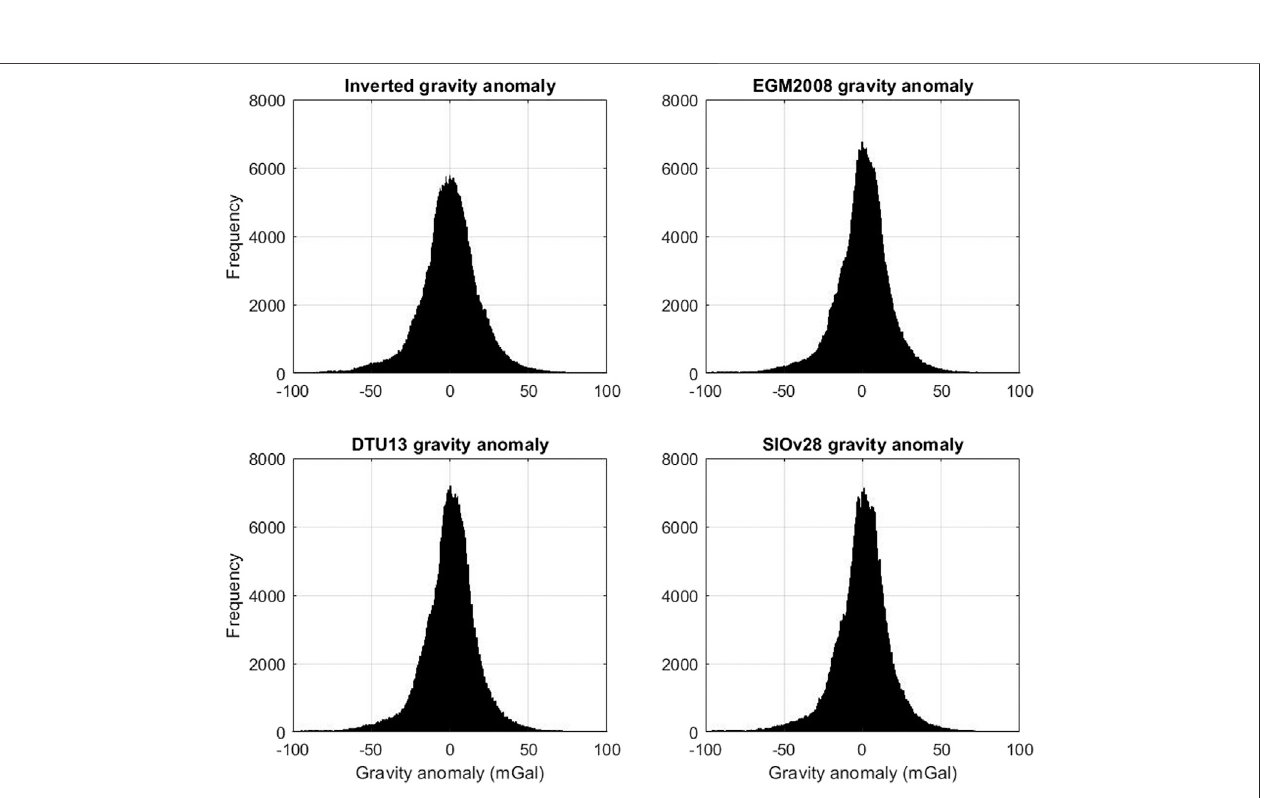
FIGURE 5 | Comparing histograms of gravity anomaly models over the study region.